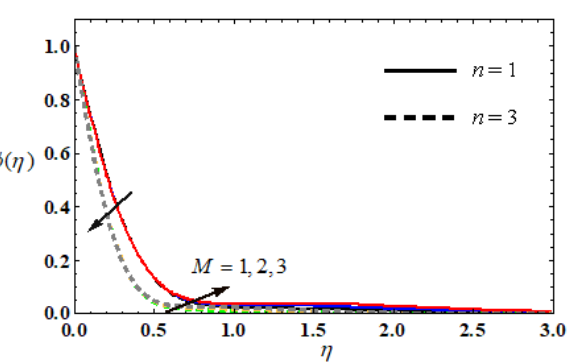
Fig. 8: Influence of M on θ ( η )